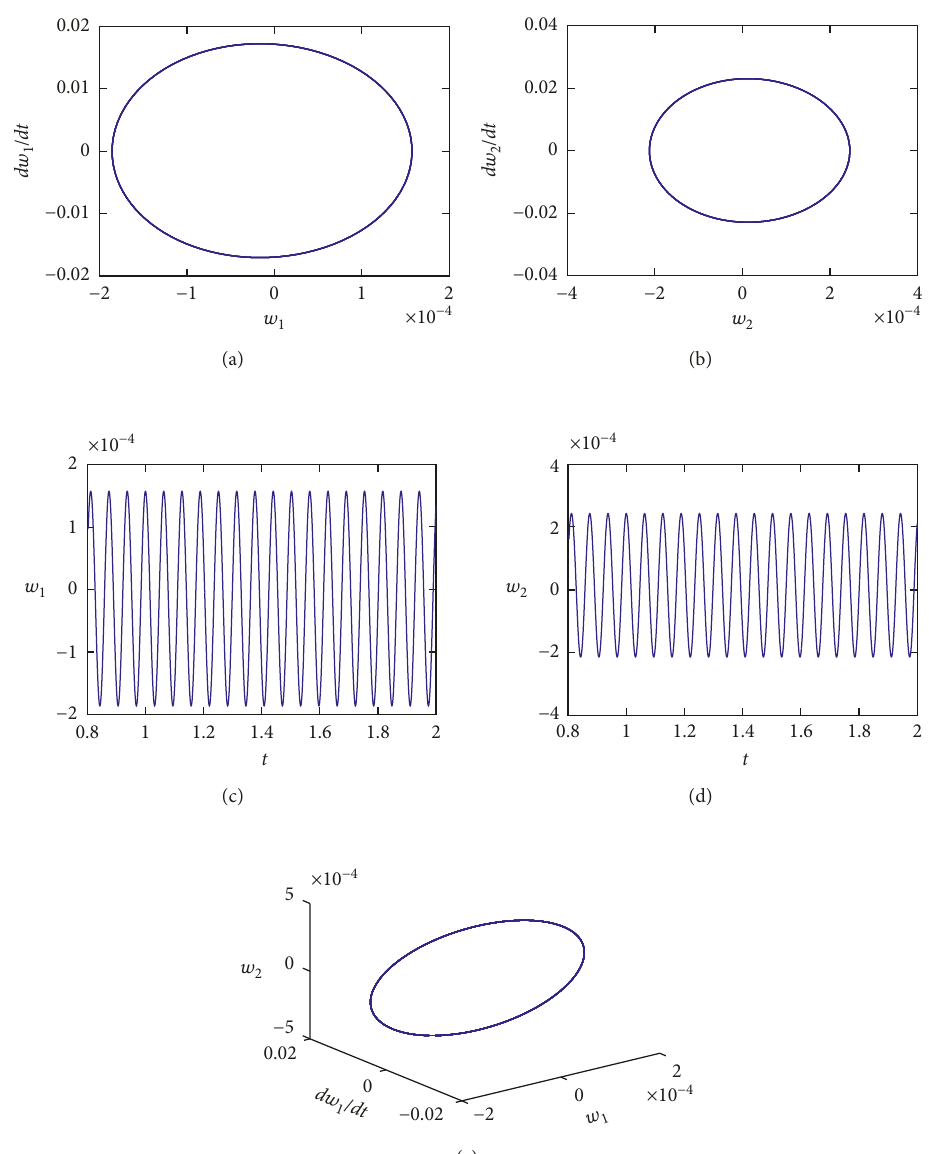
Figure 8: Periodic motion of the cantilever honeycomb sandwich